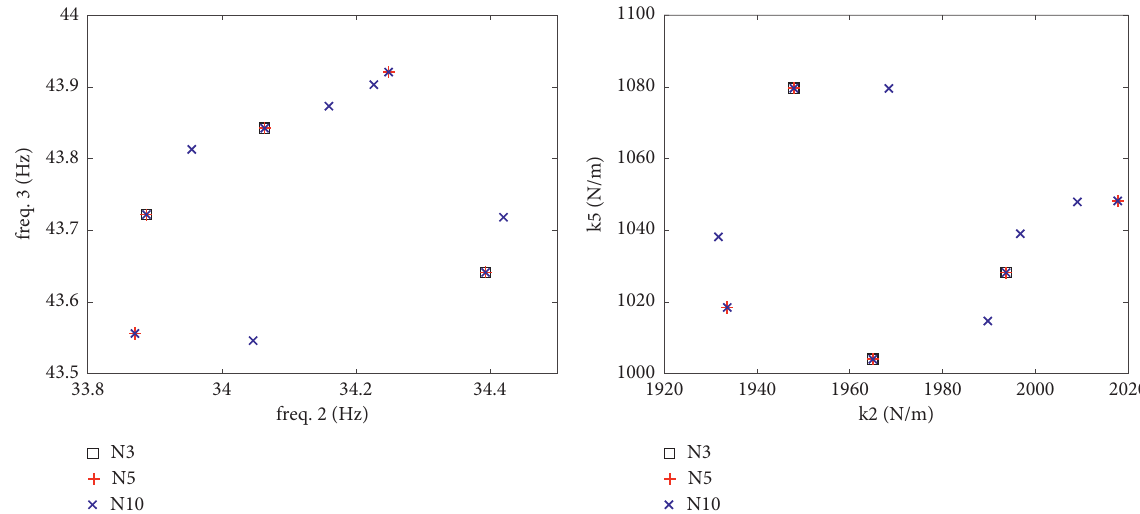
014.51515.516 Figure 8: The sequence of MCMC samples for parameter a to verify the convergence and